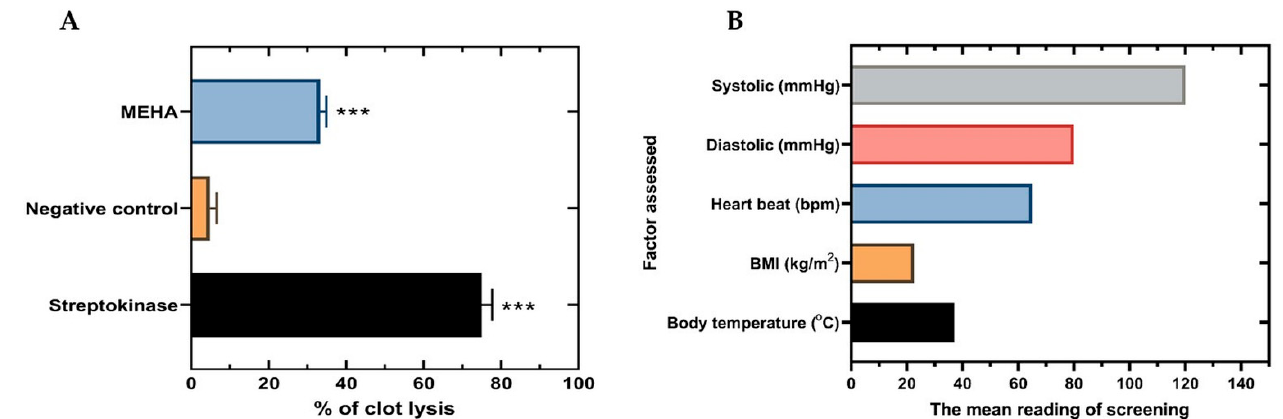
Figure 2. ( A ) The clot lysis activity of MEHA, streptokinase (SK) and distilled water (negative control). ( B ) The healthy volunteer status presented. Results are expressed as mean ± SEM of three independent experiments. *** p < 0.001, significantly different from control; ANOVA followed by Dunnett’s test. MEHA: Methanol extract of Homalomena aromatica leaves.